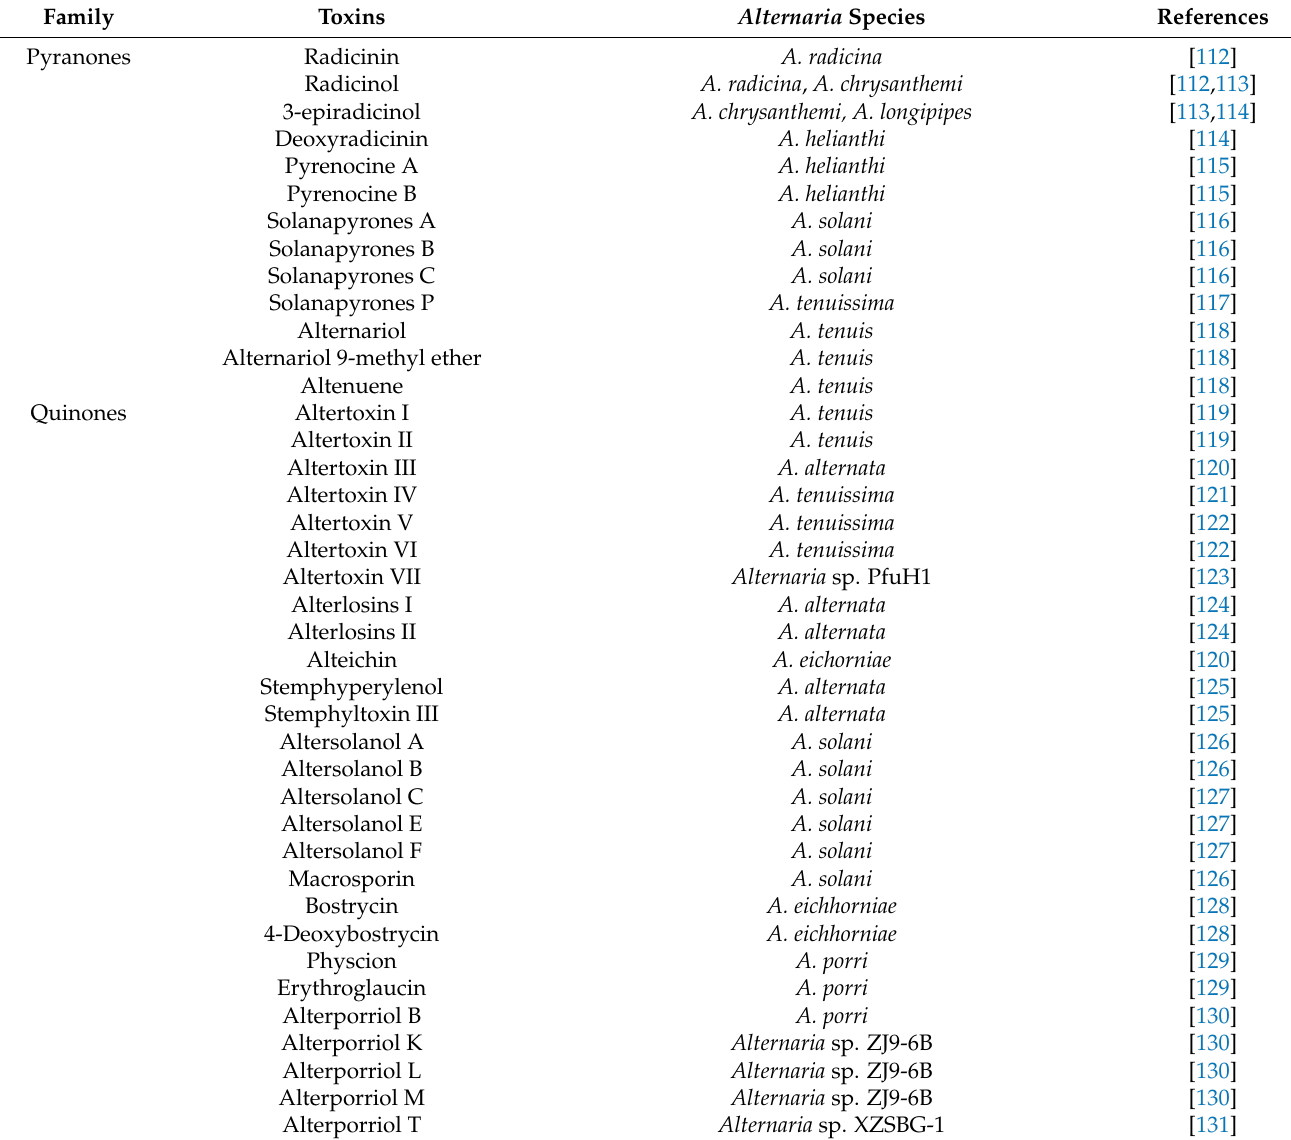
Table 2. NHSTs produced by Alternaria